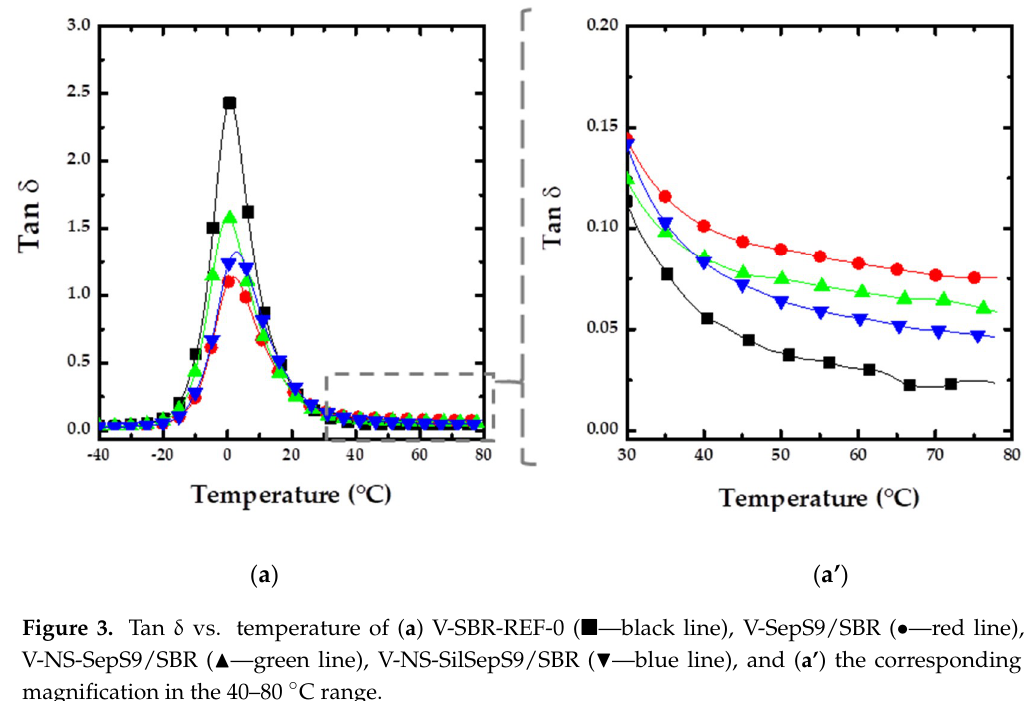
Figure 3. Tan δ vs. temperature of ( a ) V-SBR-REF-0 ( ■ —black line), V-SepS9/SBR (●—red line), V-NS-SepS9/SBR ( ▲ —green line), V-NS-SilSepS9/SBR ( ▼ —blue line), and ( a’ ) the corresponding magnification in the 40–80 °C range. Table 1. E’, E’’, and Tan δ at 30 and 70 °C and Tg from E of SepS9 PNCs.